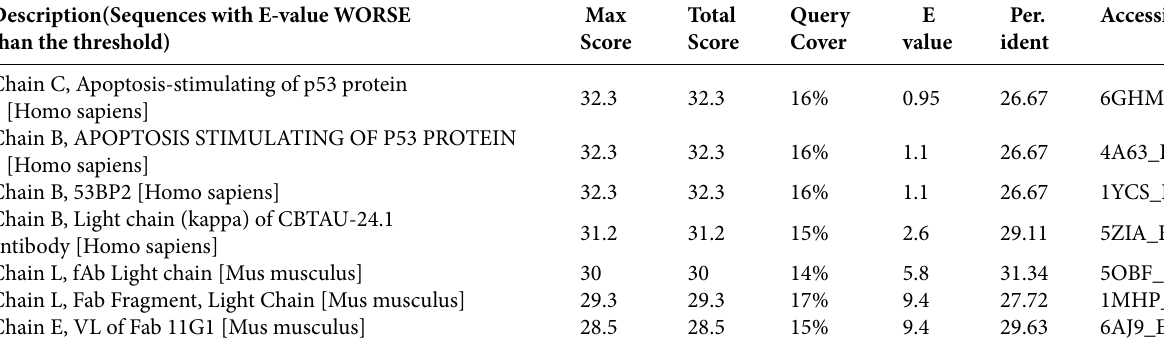
Table 1. The list of PSI-BLAST results of the amino acid sequence of Aggregatin. The list of homolog proteins is arranged according to their percent identities with Aggregatin. According to the outcomes, the percent identity of the proteins ranges between 31-26%. Description(Sequences with E-value WORSE Max Total Query E Per. than the threshold) Score Score Cover